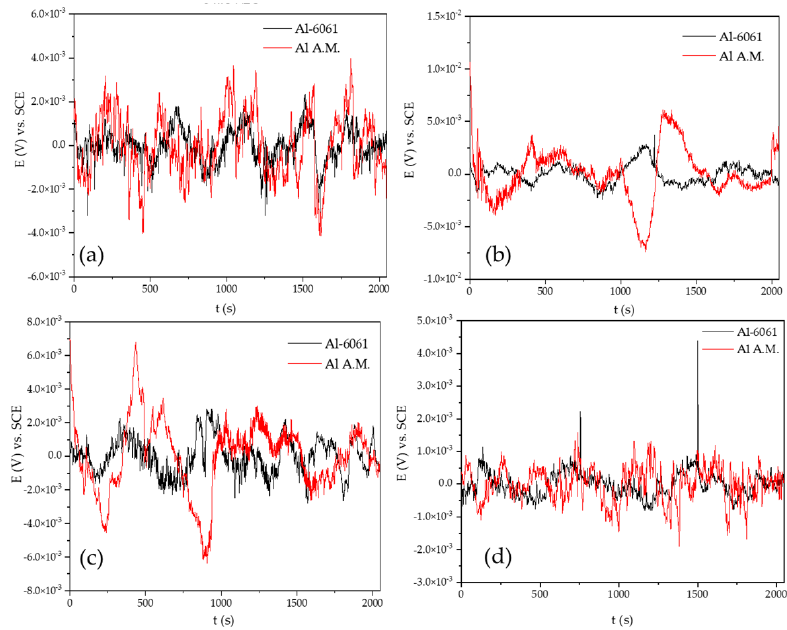
Figure 2. Time series electrochemical potential noise (EPN) data in H 2 O solution: ( a ) 0 h, ( b ) 24 h, ( c ) 48 h, and ( d ) 120 h.